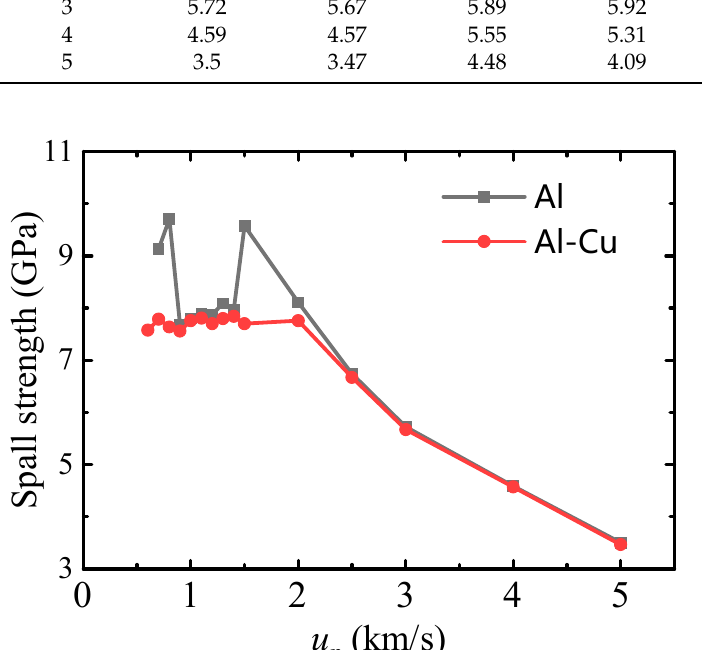
Figure 3. Spall strength at various piston velocities for the crystal with Cu inclusion and the per- fect crystal. Table 1. Spall strengths given by the maximum tensile stress ( sp rate 𝜀(cid:4662) given by Equation (2).